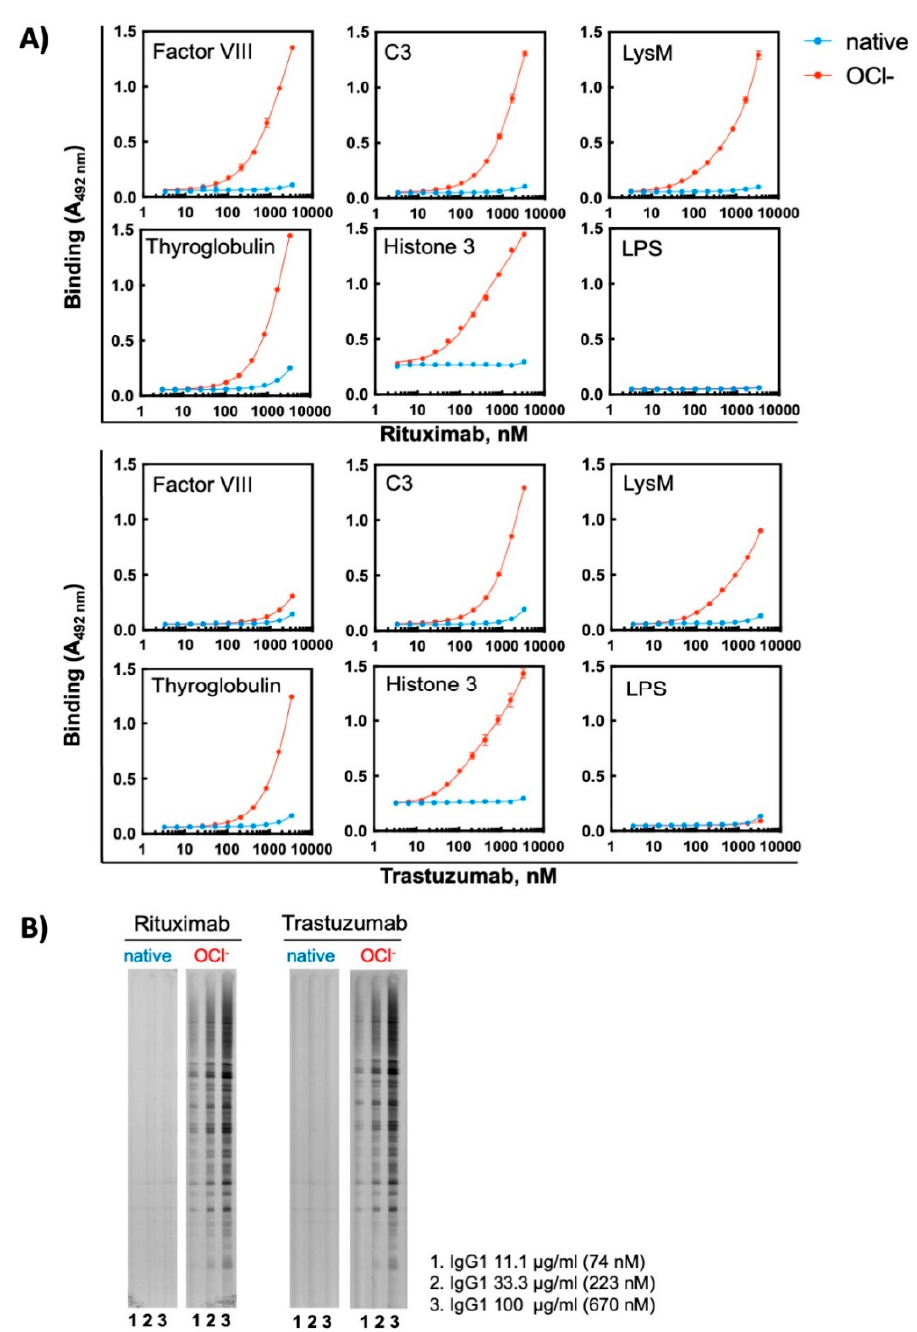
Figure 5. Treatment of therapeutic Abs—Rituximab and Trastuzumab—with hypochlorite ions results in induction of antigen-binding polyreactivity. ( A ) ELISA assay was used to evaluate the reactivity of native and OCl − ion-exposed Rituximab or Trastuzumab. The Abs at 1 mg/mL (6.7 µ M) were treated with 200 µ M final concentration of NaOCl. After native and hypochlorite ion-treated Abs were serially diluted 3350—3.27 nM and incubated with the indicated proteins and LPS from E. coli immobilized on ELISA plates. Each symbol represents the averaged binding intensity obtained from triplicate samples ± SD. ( B ) Immunoblot analyses of reactivity of native and hypochlorite ion-exposed Rituximab and Trastuzumab to antigens from total lysate from Bacillus anthracis . Abs were treated at 1 mg/mL (6.7 µ M) with 200 µ M NaOCl. Next native and treated Abs were diluted to 100, 33 and 11 µ g/mL and incubated with the immobilized antigens using Immunetics miniblot system.